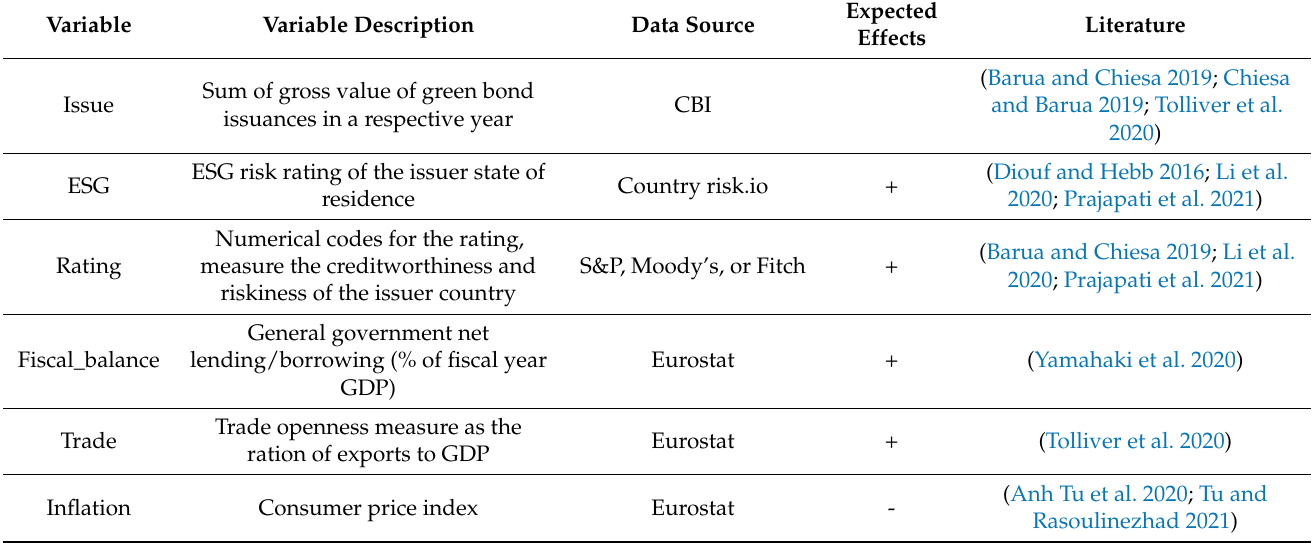
Table 2. Green bond market barriers and